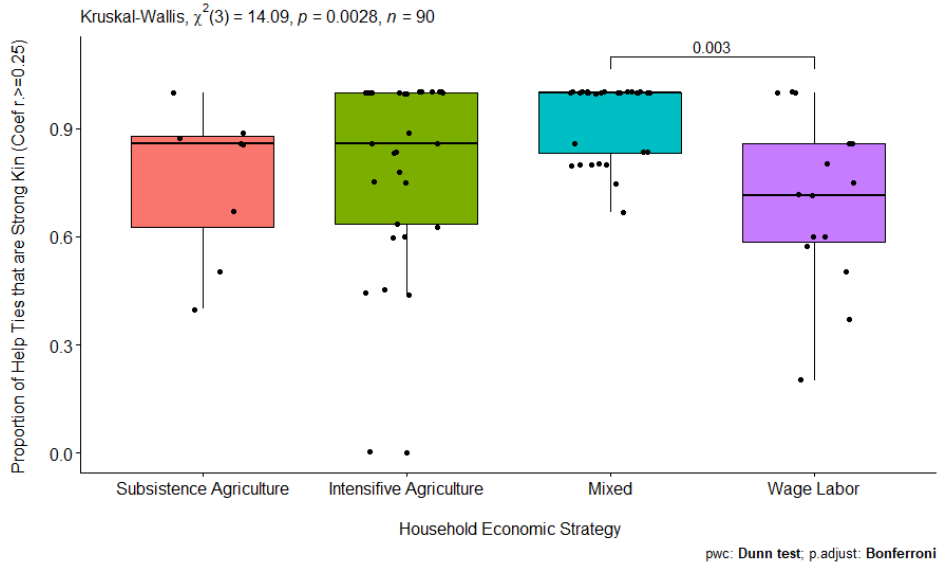
Figure 4. Proportion of support ties composed of kin stratified by household economic strategy.